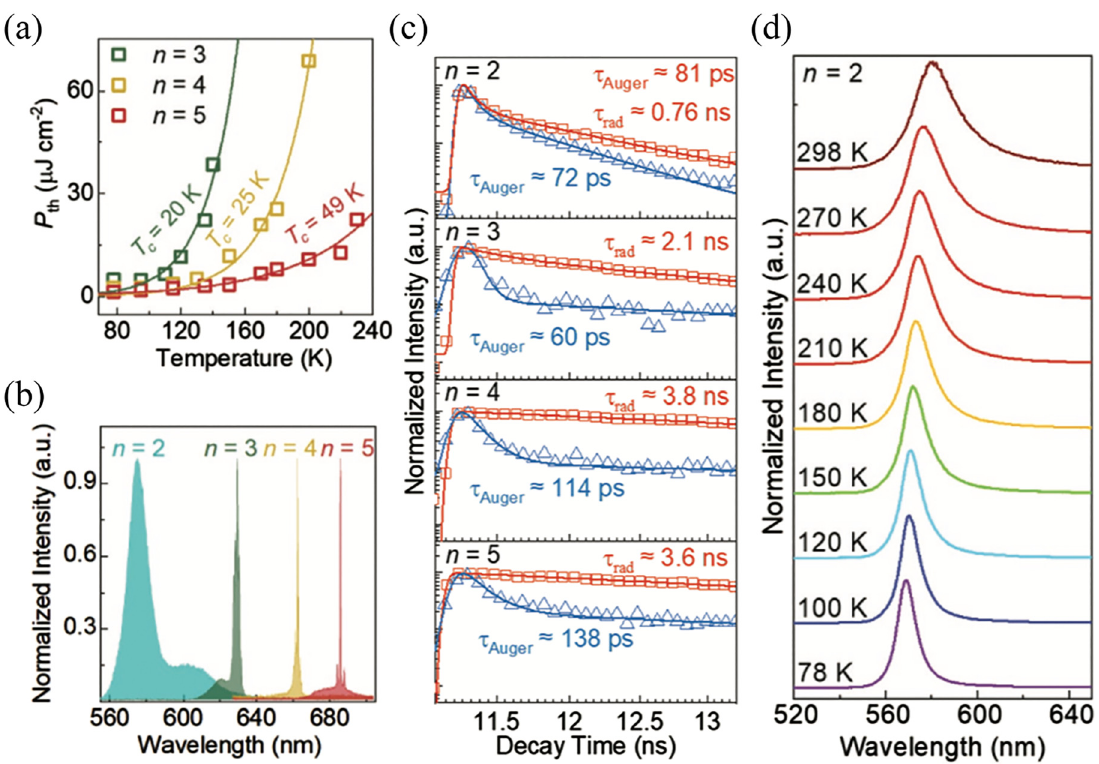
Figure 4: (a) Temperature-dependent lasing threshold for n = 3, 4, 5 perovskite micro fl akes. (b) Lasing spectra of n = 3, 4, and 5 perovskite micro fl akes at 78 K. No lasing was observed for n = 2 perovskite micro fl akes. (c) The transient PL decay curves for n = 2, 3, 4, 5 perovskite micro fl akes under low (red) and high (blue) excitations. (d) PL spectra for n = 2 perovskite micro fl akes under temperatures from 78 to 298 K. Reproduced with permission [56]. © 2019 WILEY ‐ VCH Verlag GmbH & Co. KGaA,